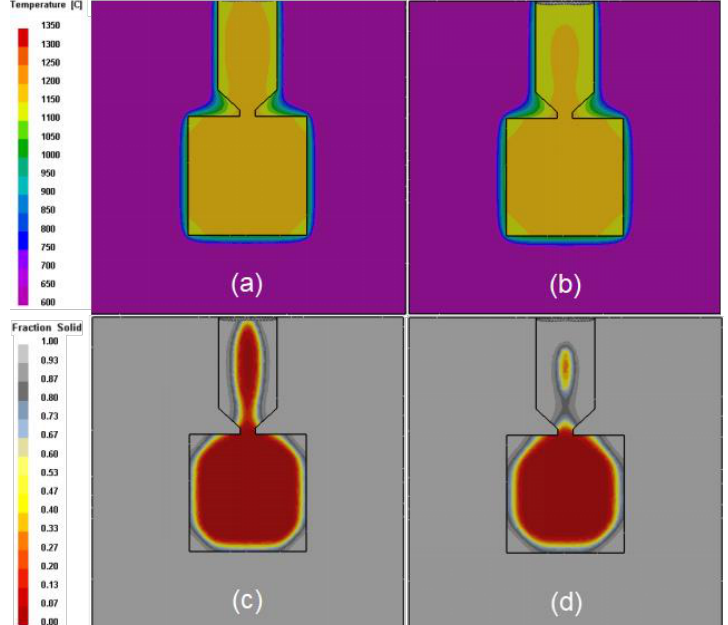
Figure 5. Solidification progress and riser top state of prototype B2 poured at 1300 ◦ C: ( a ) Temperature field of casting and mold at the early stage; ( b ) Temperature field of casting and mold during further cooling and solidification; ( c ) Solid fraction distribution when the riser top solidified; ( d ) Mushy zone in the casting and riser was isolated by the riser